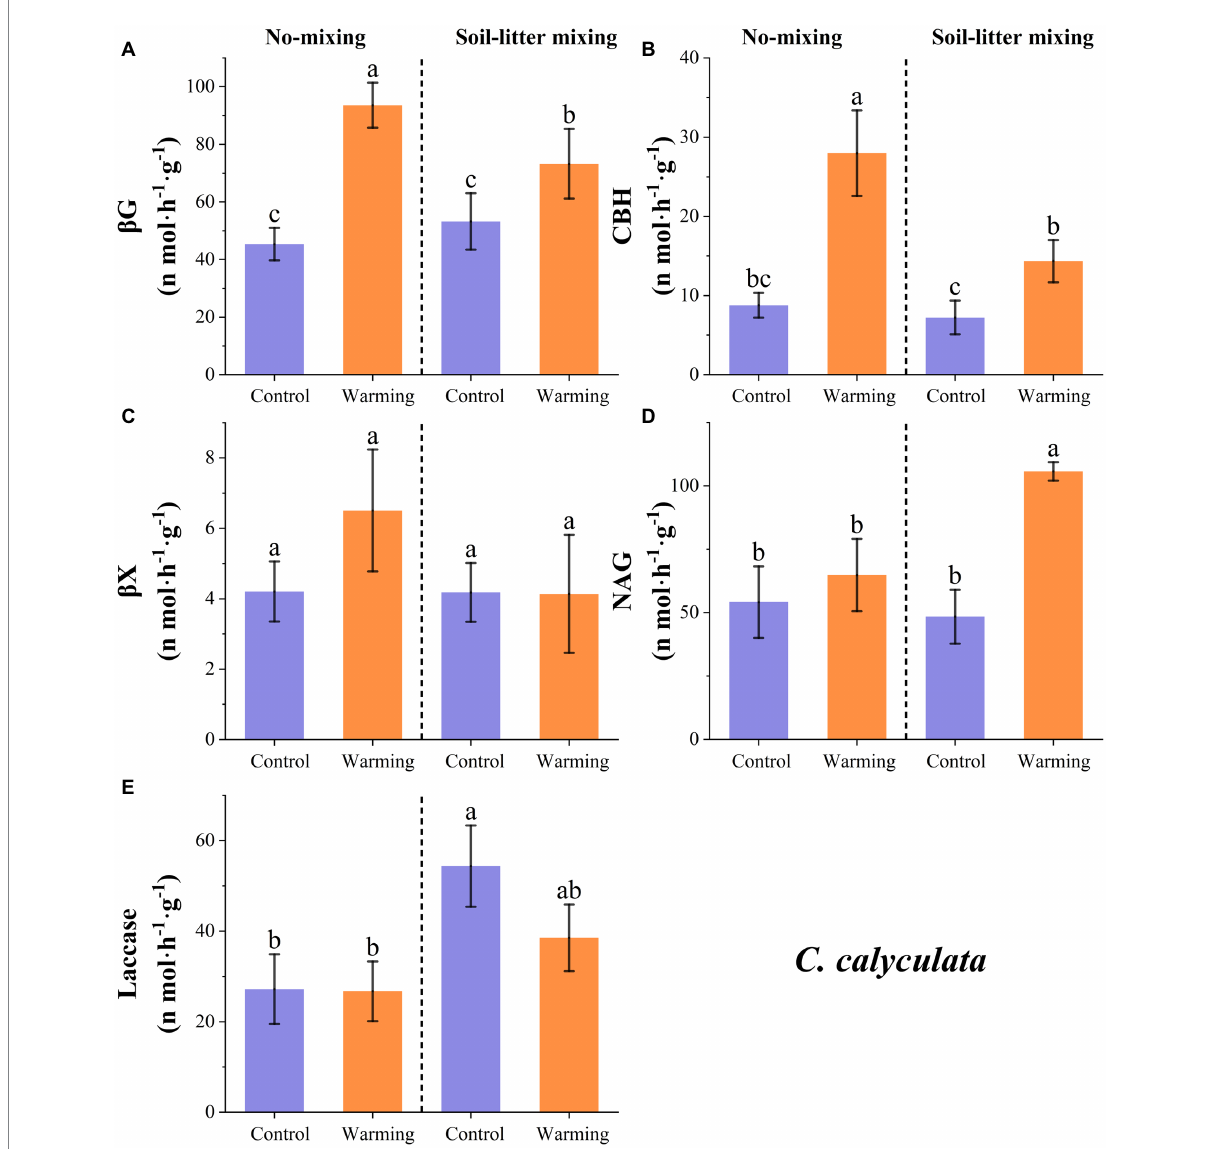
FIGURE 2 The responses of the potential enzyme activities of C. calyculata to warming under the no-mixing and soil-litter mixing treatments. The enzymes are (A) β -glucosidase ( β G), (B) Cellobiohydrolase (CBH), (C) β -xylosidase ( β X), (D) N-acetyl-glucosaminidase (NAG), and (E) Laccase. The values are the mean ± standard deviation of each treatment ( n = 4). The different letters indicate significant differences ( p < 0.05) in the enzyme activities under the different